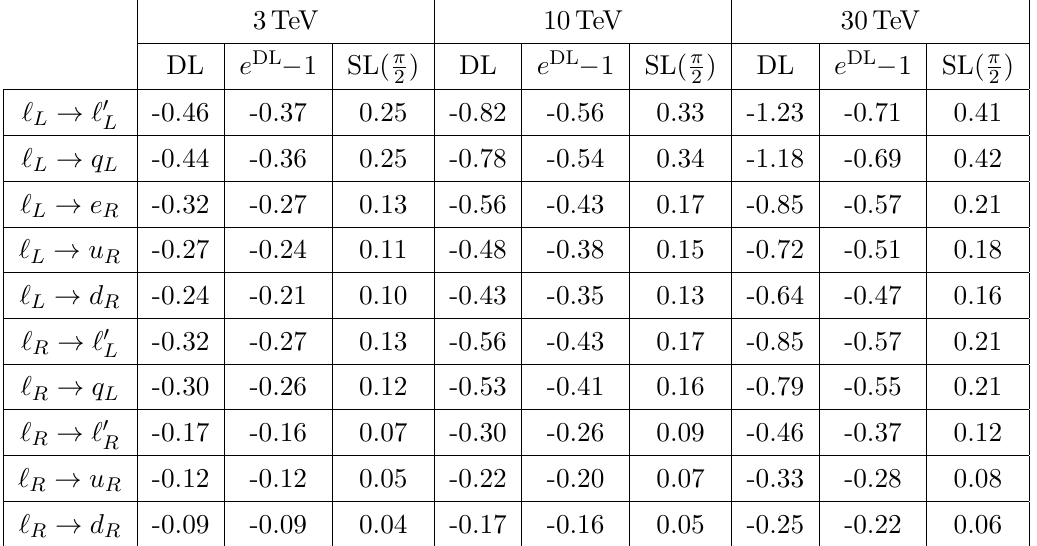
Table 1. Double and single logarithmic corrections to the exclusive processes ‘ + ‘ − → single-logarithmic corrections are evaluated at θ